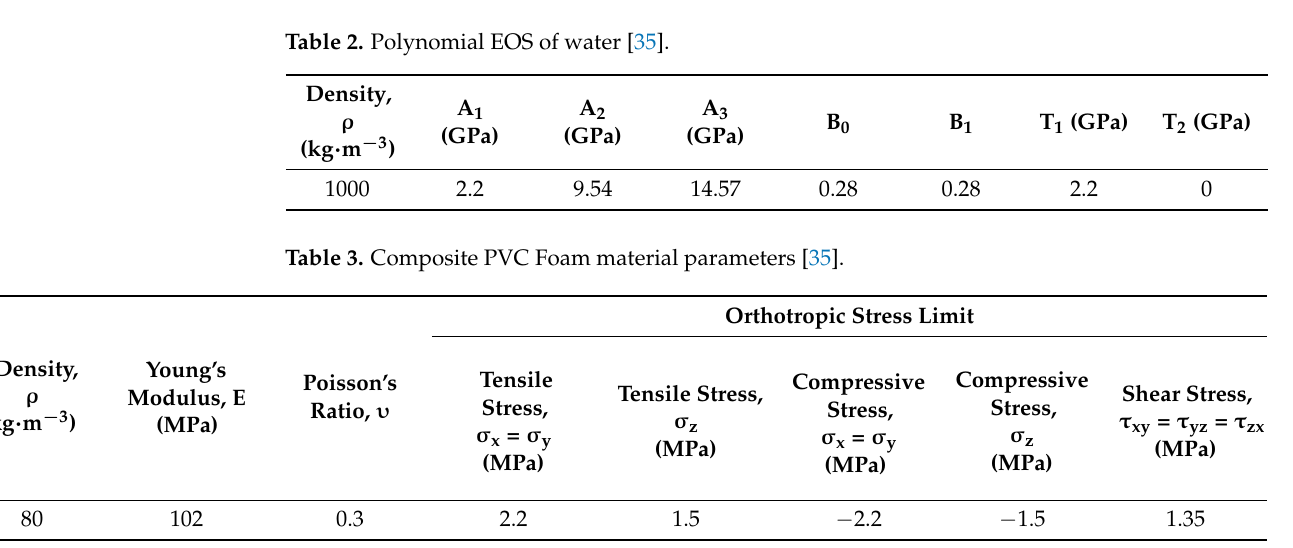
Table 1. Mechanical properties of Aluminum Alloy [33] .